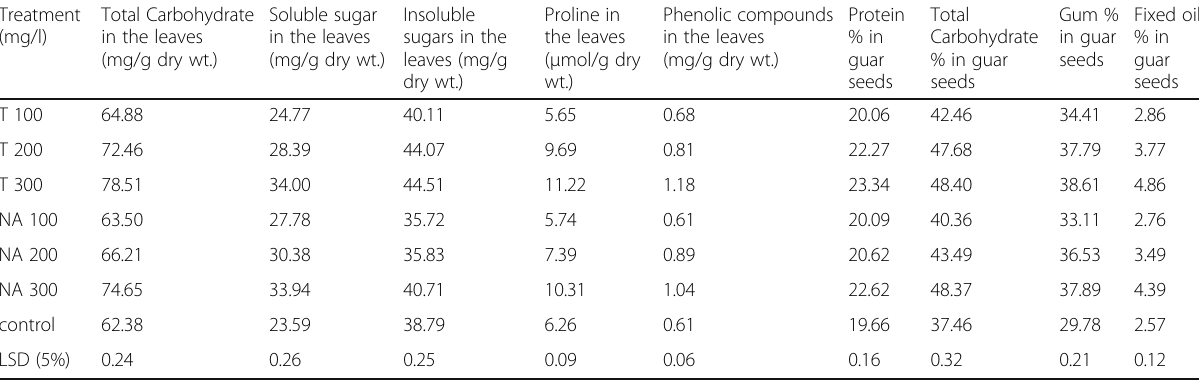
Table 4 Effect of tryptophan and nicotinamide on chemical constituents of guar plants Treatment Total Carbohydrate (mg/l) in the leaves (mg/g dry